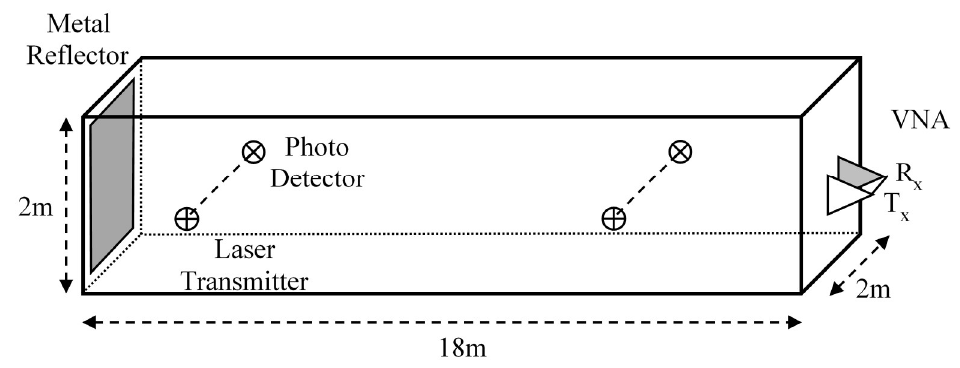
Figure 4. Schematic illustration of experimental setup [16].